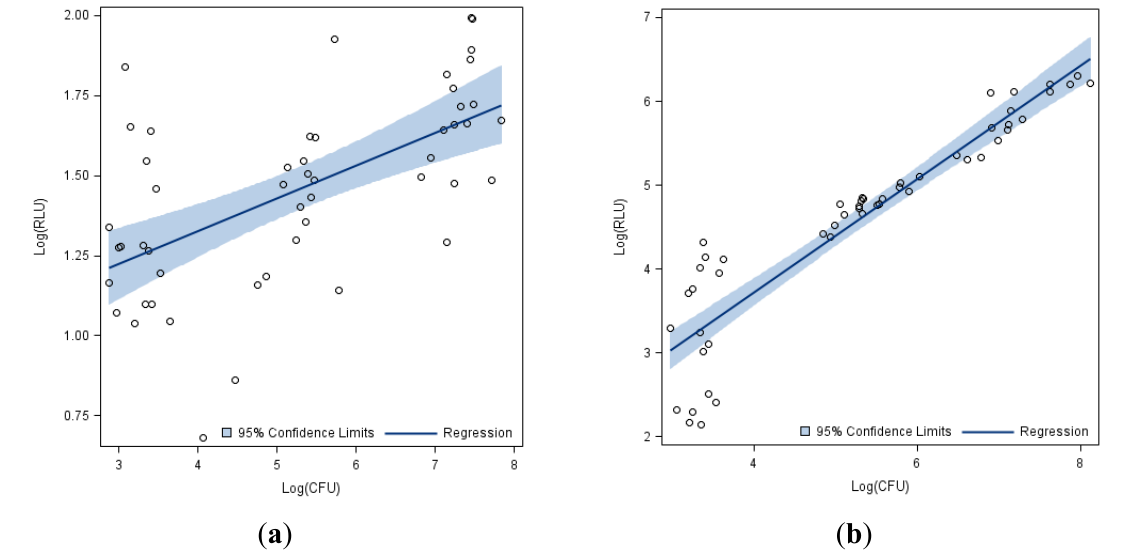
Figure 1. Log adjusted Relative Light Units (RLU) from ATP bioluminescence assay vs. Log adjusted Colony Forming Units (CFU) from culture-based methods for B. anthracis across